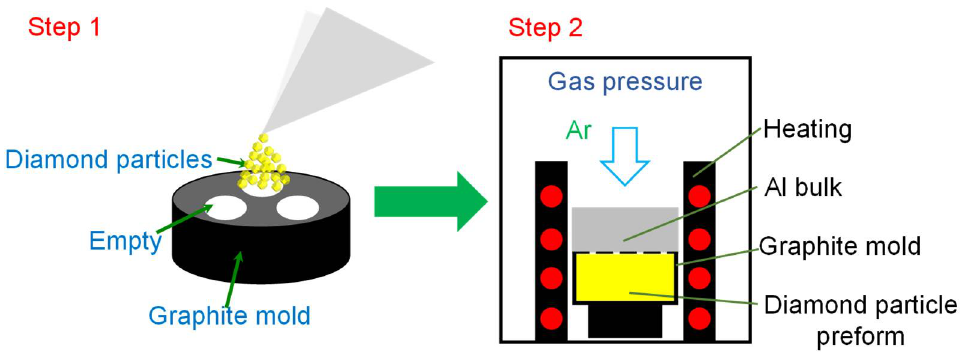
Figure 1. Schematic illustration of the preparation of the diamond/Al composites by gas pressure Figure 1. infiltration. pressure infiltration.